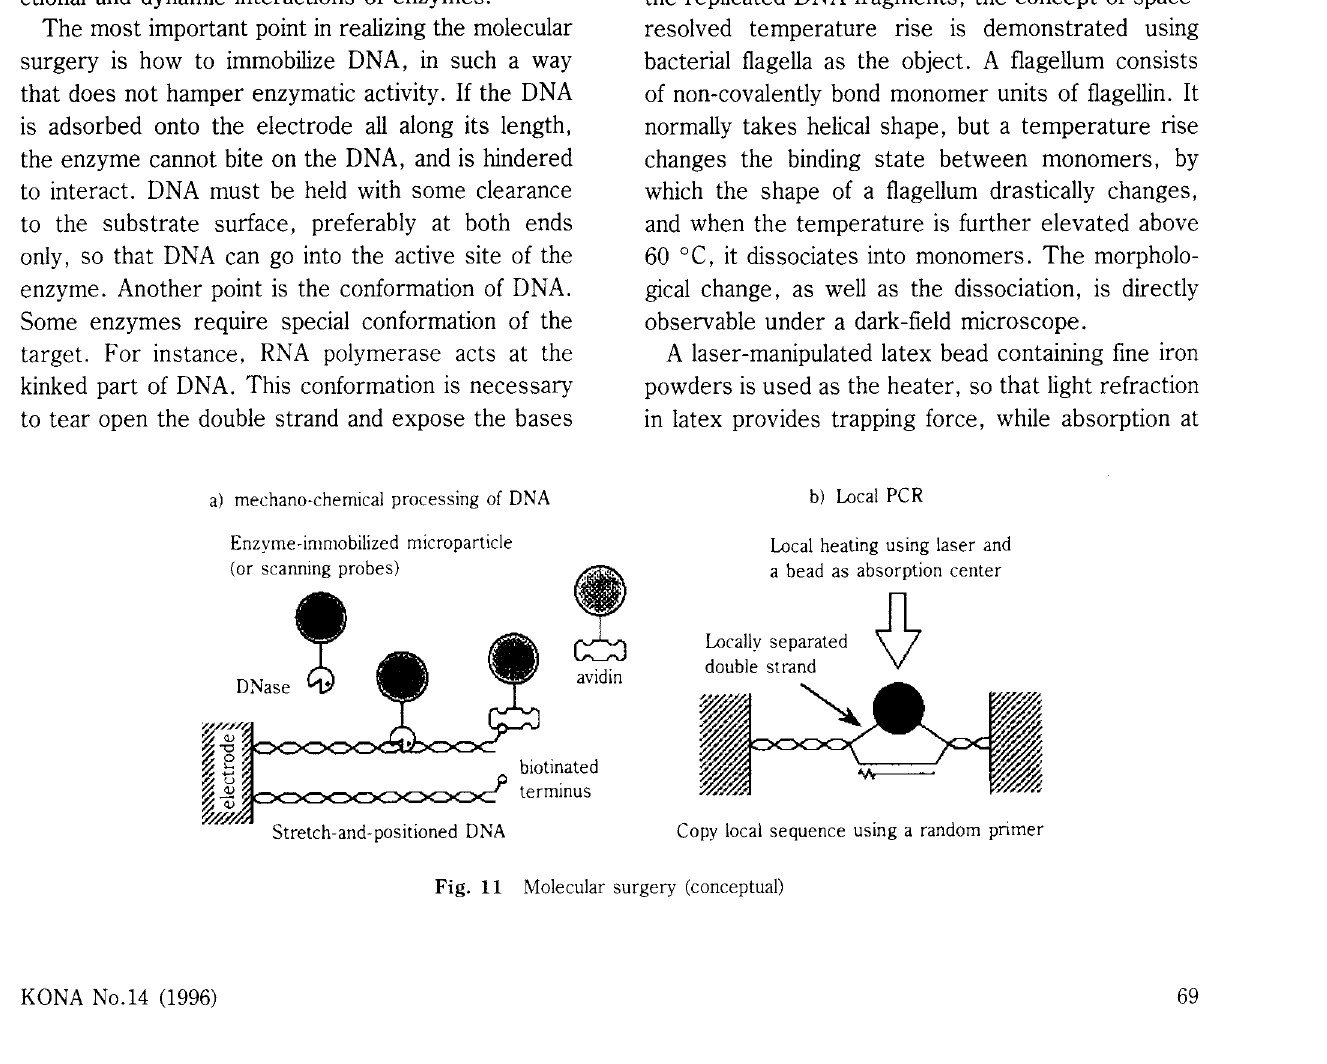
Fig. 10 Floating-potential electrode geometry for site-specific immobilization of DNA with variable margin fragment is biotinated prior to dissection. The method also can be used for biophysical studies of the fun ctional and dynamic interactions of